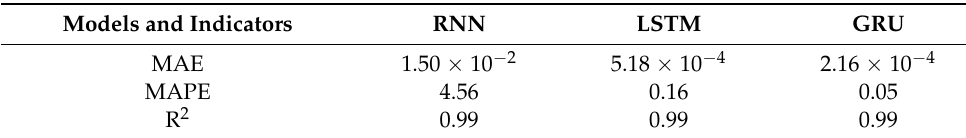
Table 3. Table of prediction effect of DL. Models and Indicators